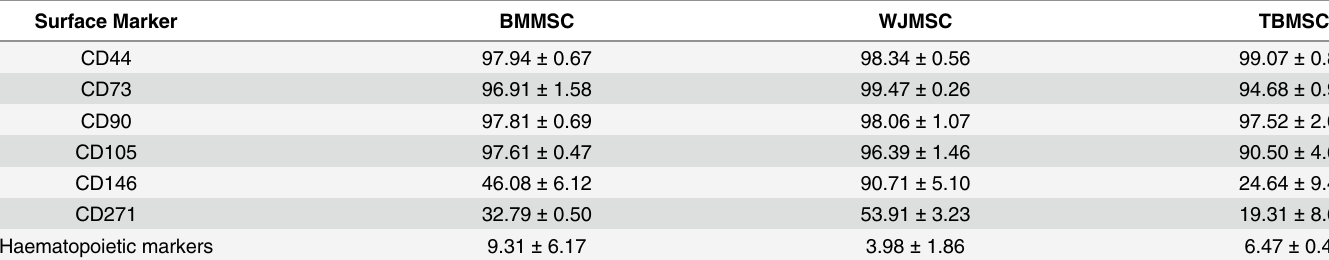
Table 1. Percentage of MSC expressing surface